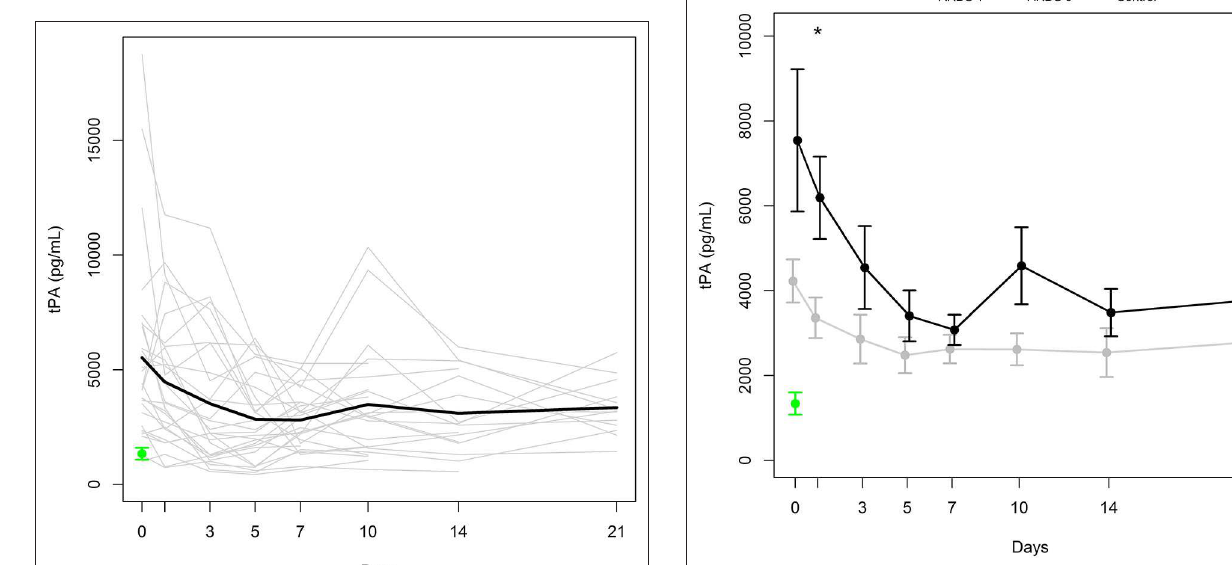
FIGURE 2 | tPA antigen levels (mean ± SEM) in a subgroup of patients with ARDS (ARDS 1, black bold line) and a subgroup with no ARDS (ARDS 0, gray bold line). *Indicates significant difference ( p = 0.020) between ARDS 1 and ARDS 0 group. Mean ± SEM of tPA in healthy controls